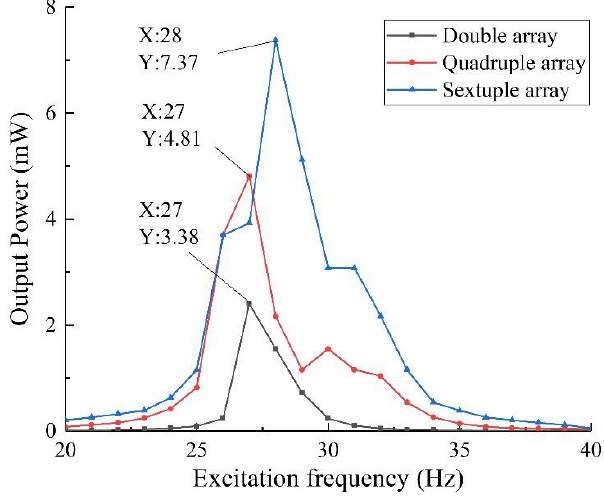
Figure 22. Output power in the 20~40 Hz band.